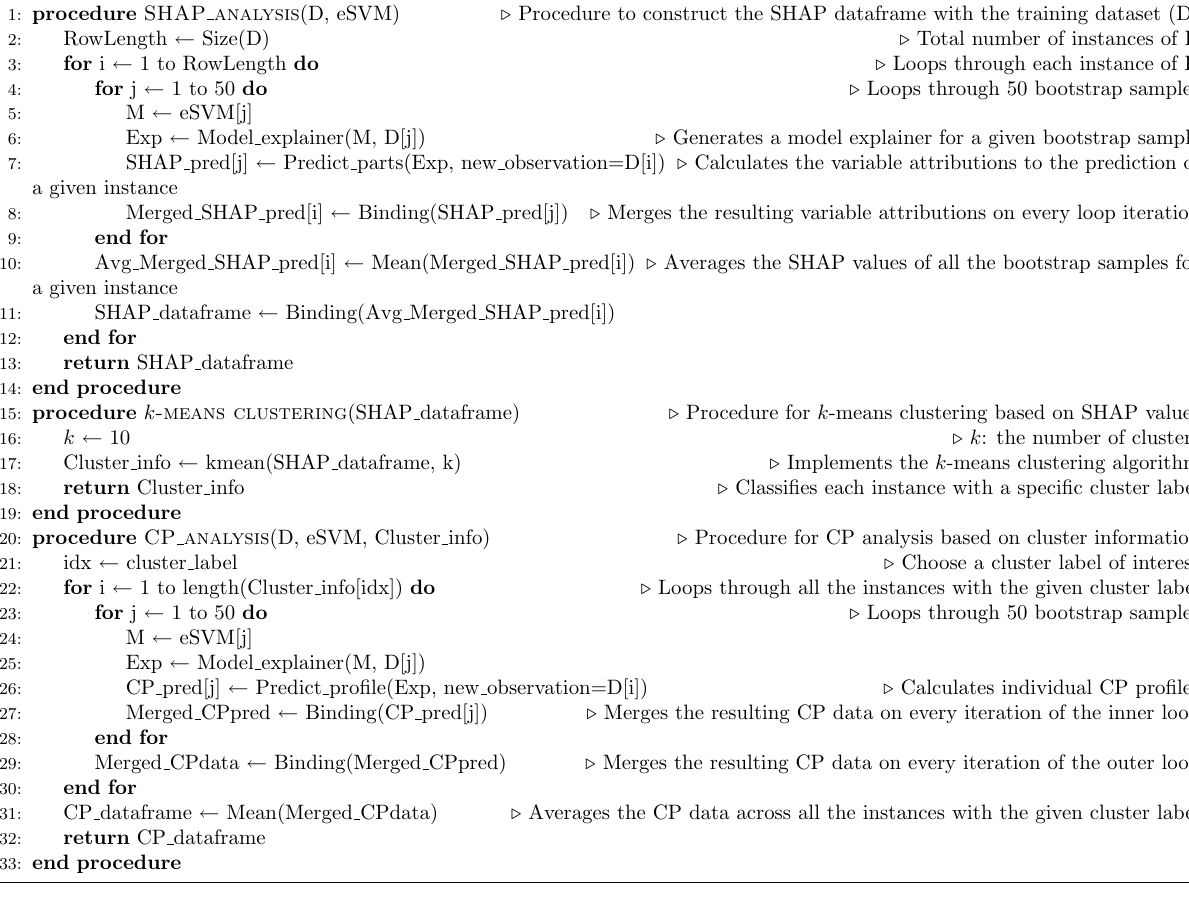
Algorithm 1. Local interpretable ML algorithm using the SHAP and CP methods along with k -means